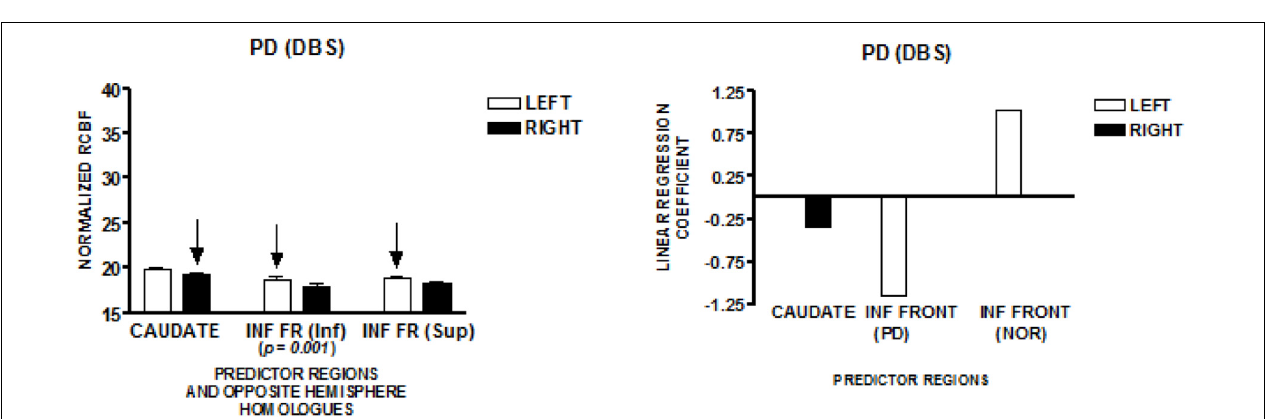
FIGURE 5 | The results from a speech production study in individuals with Parkinson’s disease treated with deep brain stimulation (DBS) using the same protocol employed in the study of normal volunteers and Parkinson’s disease in New York (NY). The graph on the left presents the mean normalized CBF ( ± SEM) for the head of the caudate nuclei, and two inferior frontal regions bilaterally. The homologous left–right pair at the lowest anatomic level of the inferior frontal region demonstrated a left greater than right normalized CBF. The graph on the right presents the linear regression weights for the three regions that predict speech rate. The negatively weighted inferior frontal region is the same region that was negatively weighted in the Parkinson’s group without DBS. The inferior frontal region that was positively weighted is the same region that was positively weighted in the NY normal group. It is interesting to note that the significant left greater than right CBF in the lower inferior frontal region is negatively weighted in the regression model (Sidtis et al.,